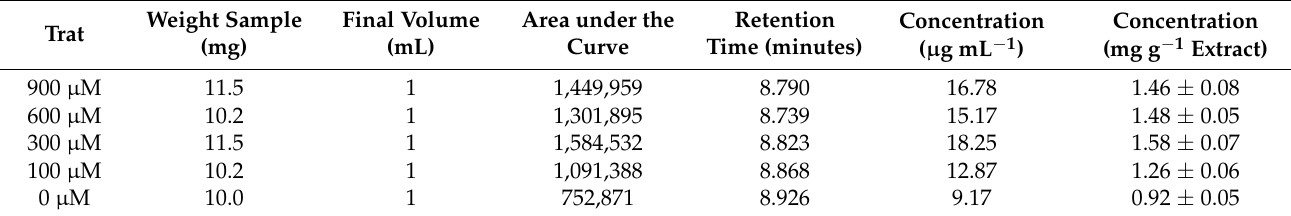
Table 4. Ricinine concentration and area under the curve of the methanolic extracts of R. communis plants treated with salicylic acid.